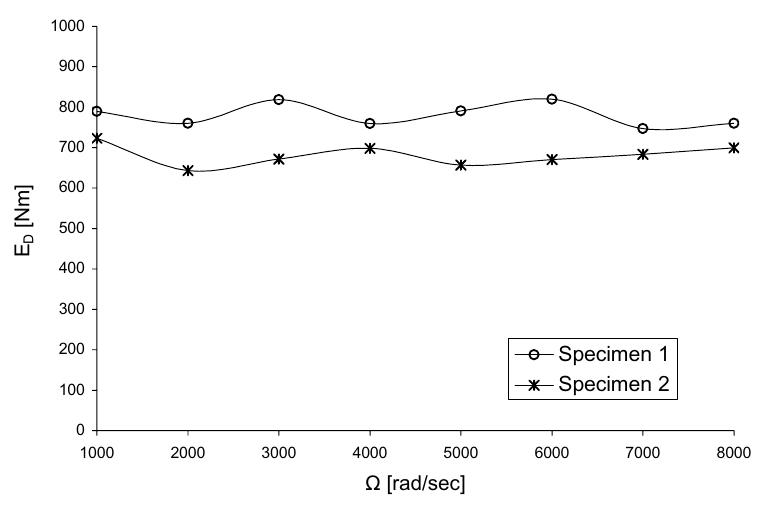
Fig. 5. Dissipated Energy per cycle of oscillation with respect to excitation